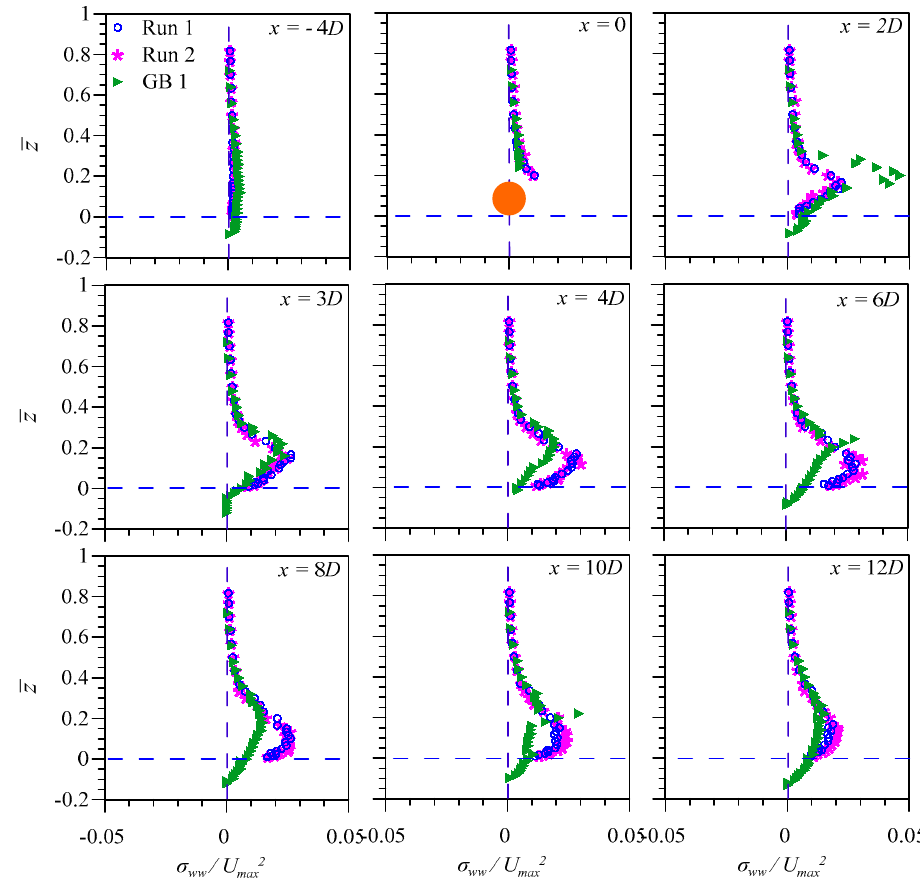
Figure 9. The variation of normalized time-averaged vertical RNS ( σ ww / U max 2 ) against normalized vertical distance ( 𝑧̅ ) at different measuring stations ( 𝑥 ) for Run 1, Run 2, and GB 1.